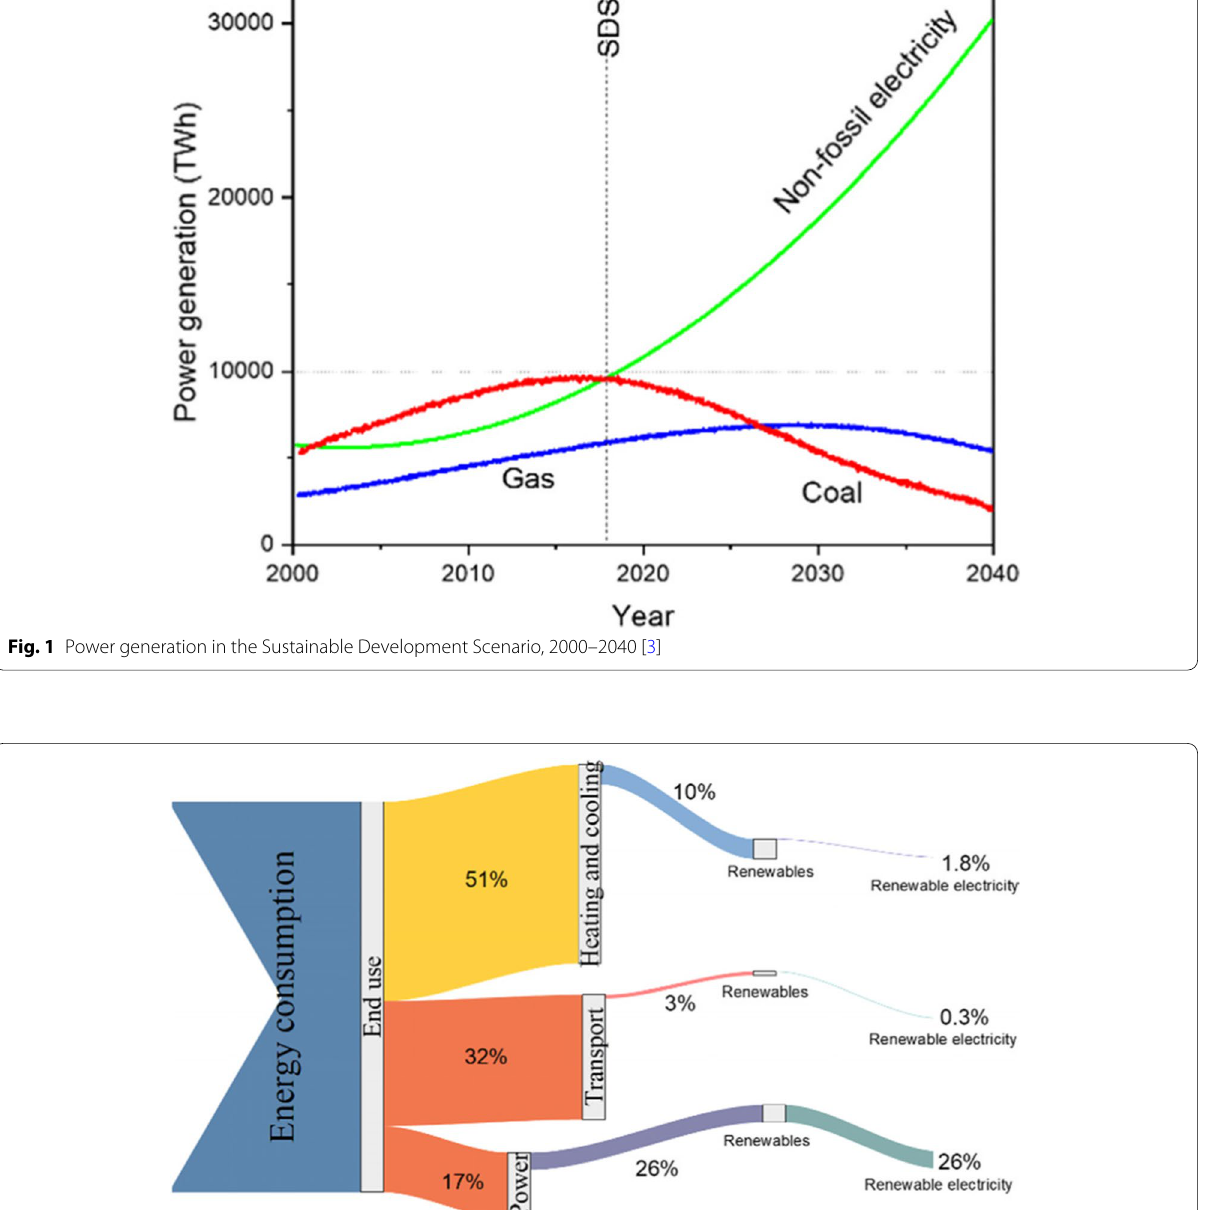
Fig. 2 Renewable energy in total final energy consumption, by Sector, 2016